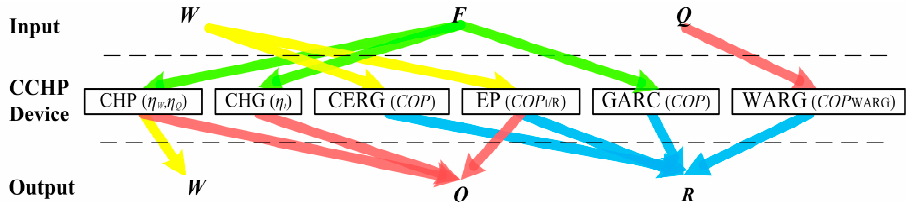
Figure 1. Energy input and output of typical multi-energy (ME) devices. CCHP: combined cooling, heat, and power; CHP: combined heat and power units; CHG: combustion heat generators; CERG: compression electric refrigeration generators; EP: electrical heat pumps; GARC: gas absorption refrigerator generators; WARG: water adsorption refrigeration generators; COP: coefficient of performance.